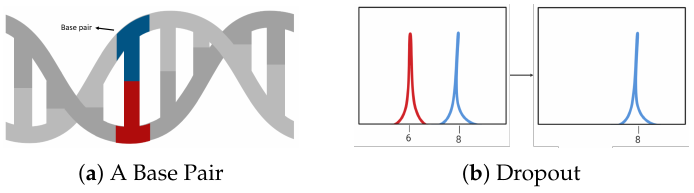
Figure 8. A base pair (size of DNA is measured by its base pairs) and